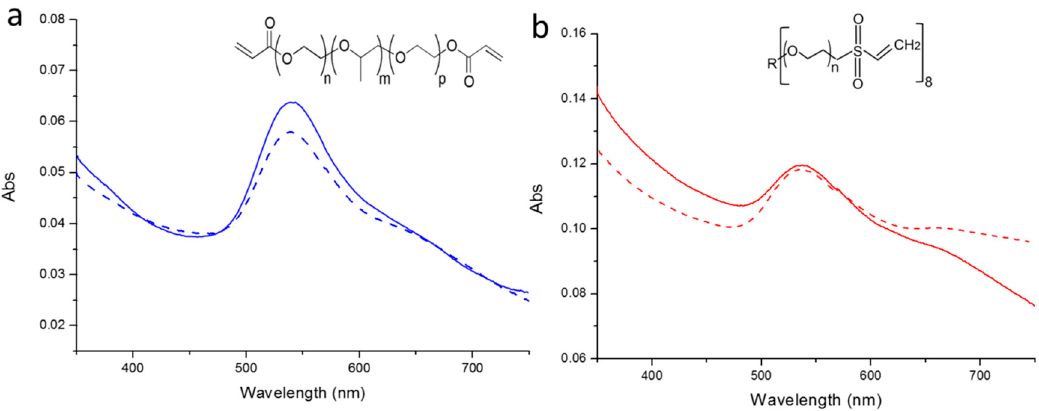
Figure 4 . UV-vis spectra of Au NPs on ( a ) 3BC-UV hydrogels and ( b ) 8PEG-VS-SH hydrogels. (solid lines represent Au NPs on the hydrogels before ultrasonication treatment; dashed lines represent Au NPs on the hydrogels after 15 min of ultrasonication treatment).